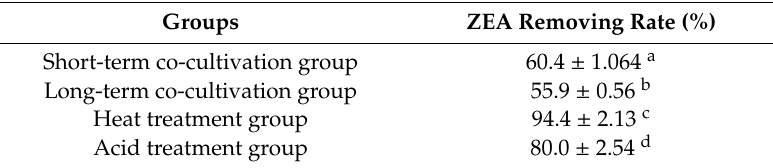
Figure 1. Determining the ability of Pediococcus pentosaceus xy46 to remove ZEA via high performance liquid-phase detection. The chromatograms correspond to the HPLC results obtained for: ( A ) the solvent control group, ( B ) the ZEA group, ( C ) the bacterial liquid control group, and ( D ) the xy46 + ZEA group. The abscissae values correspond to the retention times of the detected substance and the ordinates to the peak absorbance intensity in each time period. Table 4. ZEA removing rates obtained using di ff erently treated